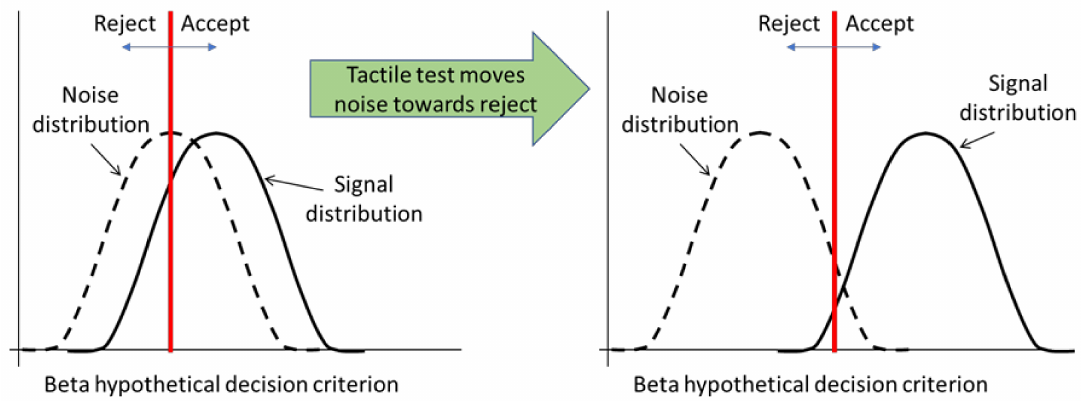
Figure 12. Tactile test improves visual inspection’s reliability by strengthening the “signal” component (damage) and filtering the “noise”